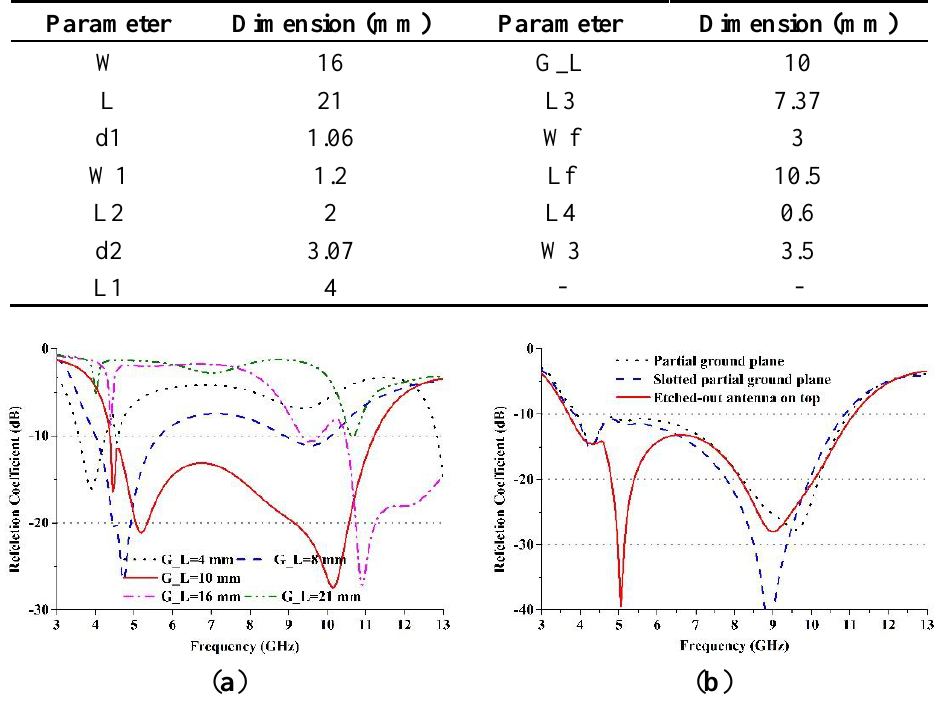
Figure 7. ( a ) The effect of the size of the ground plane, G_L, on the reflection coefficient; ( b ) comparisons between the reflection coefficient of the partial ground plane, G_L = 10 mm, slotted partial ground plane, and etched-out antenna on top of the slotted partial ground